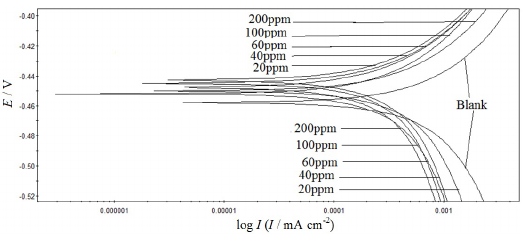
Figure 4. Tafel plots for mild steel in 1.0M HCl solution in the absence and presence of the inhibitor at various concentrations.